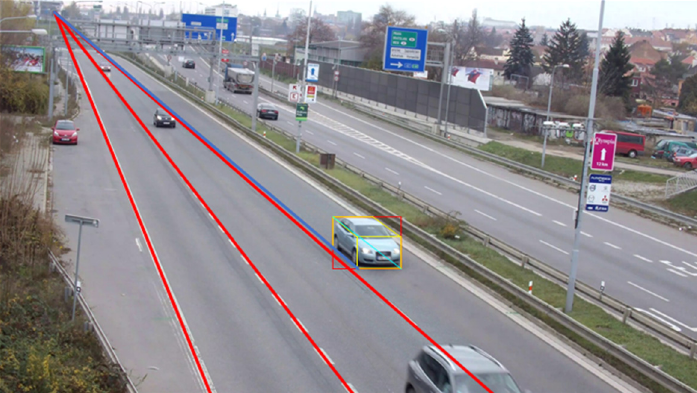
Figure 8. Schematic diagram of geometric constraints.